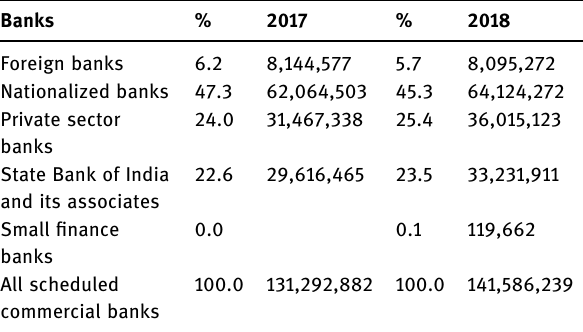
Table 1: Ownership wise total assets of banks for the year